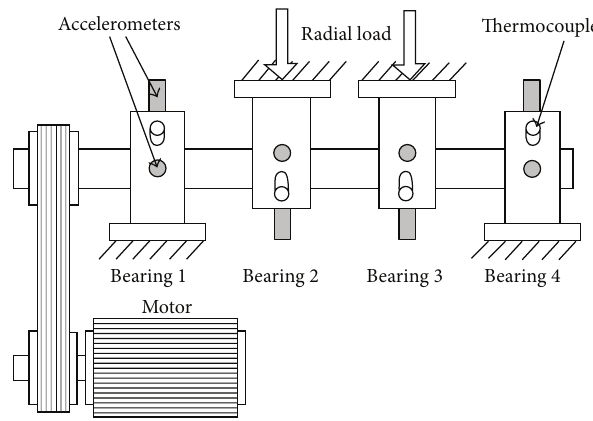
Figure 5: Bearing experimental setup [27].